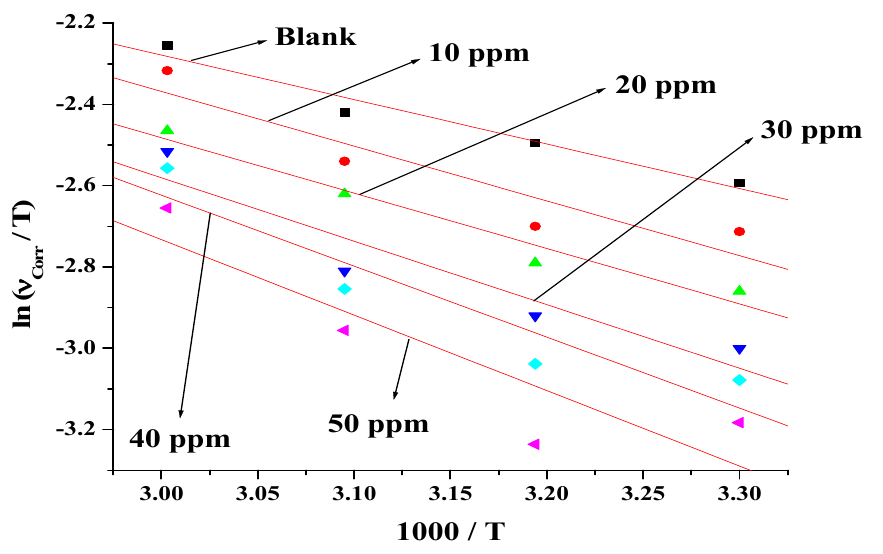
Figure 13. Transition state plot for soft-cast steel without and with the addition of different concen- trations of olmesartan in 1 mol dm − 3 HCl at temperatures ranging from 303 K to 333 K.